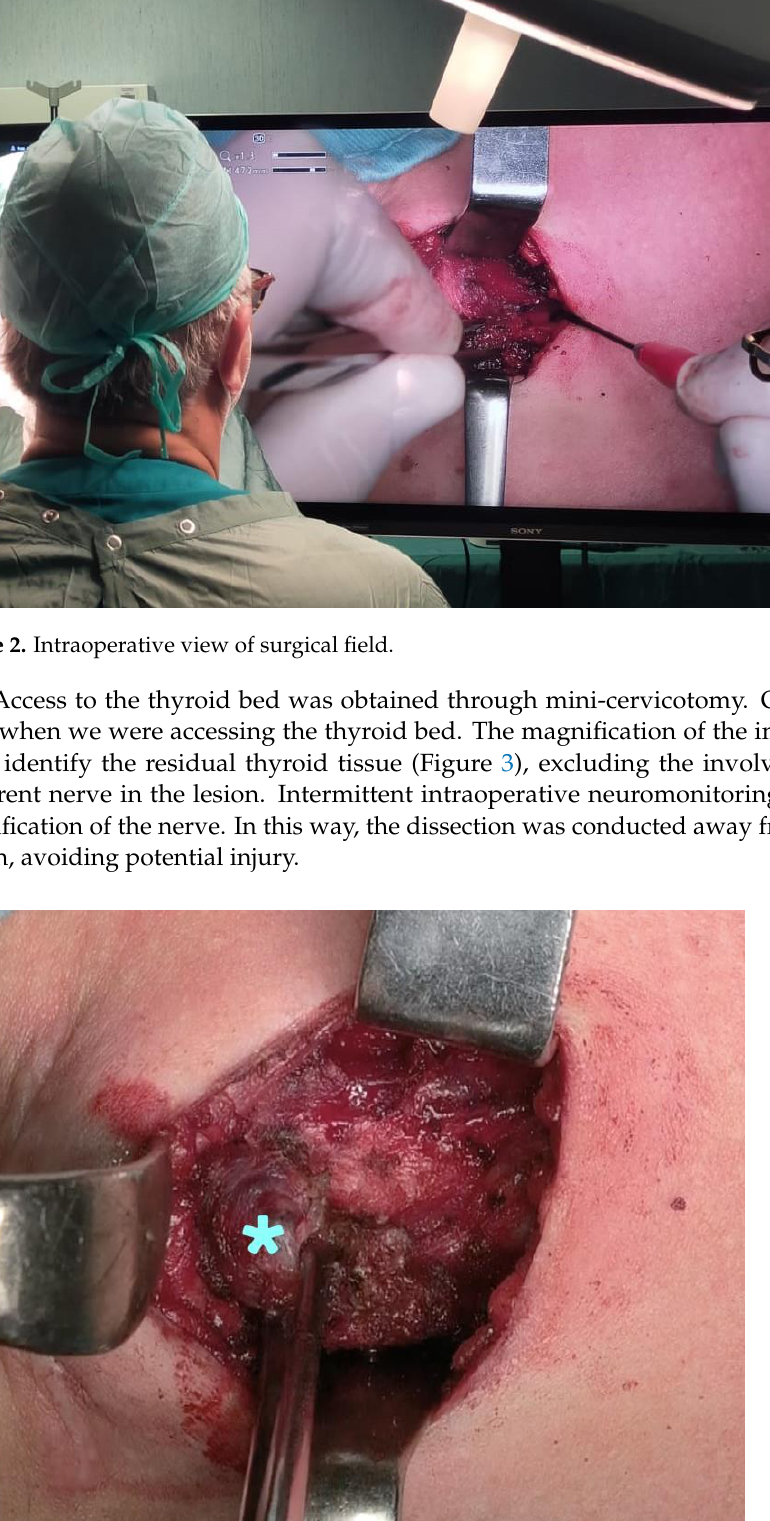
Figure 1. Orbeye exoscope 4K 3D and operating room setting.